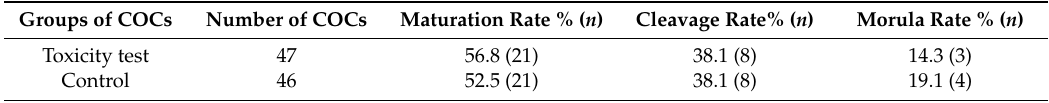
Table 1. Analyzed parameters related to oocyte maturation, fertilization, and embryo development with regard to exposure to cryoprotectants in vitrification